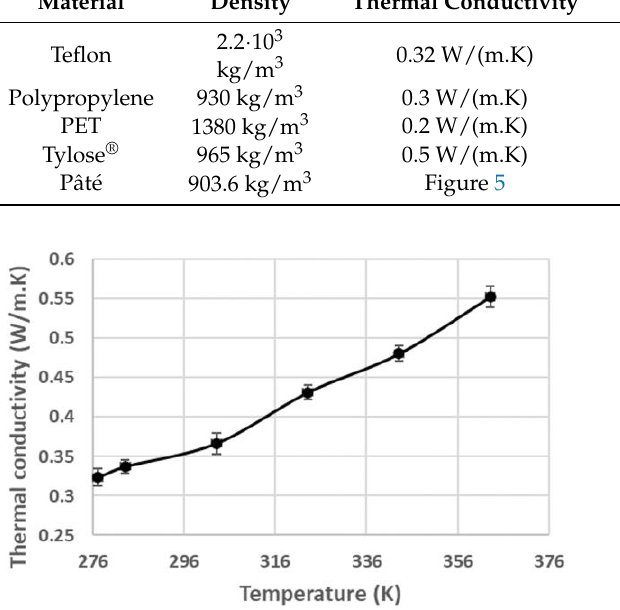
Figure 5. Thermal conductivity of pâté at various temperatures.